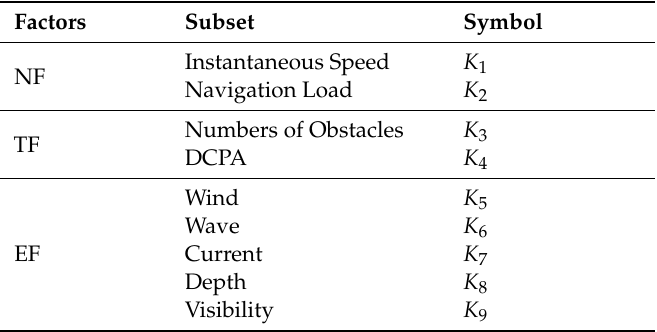
Table 2. Factors influencing the size of the